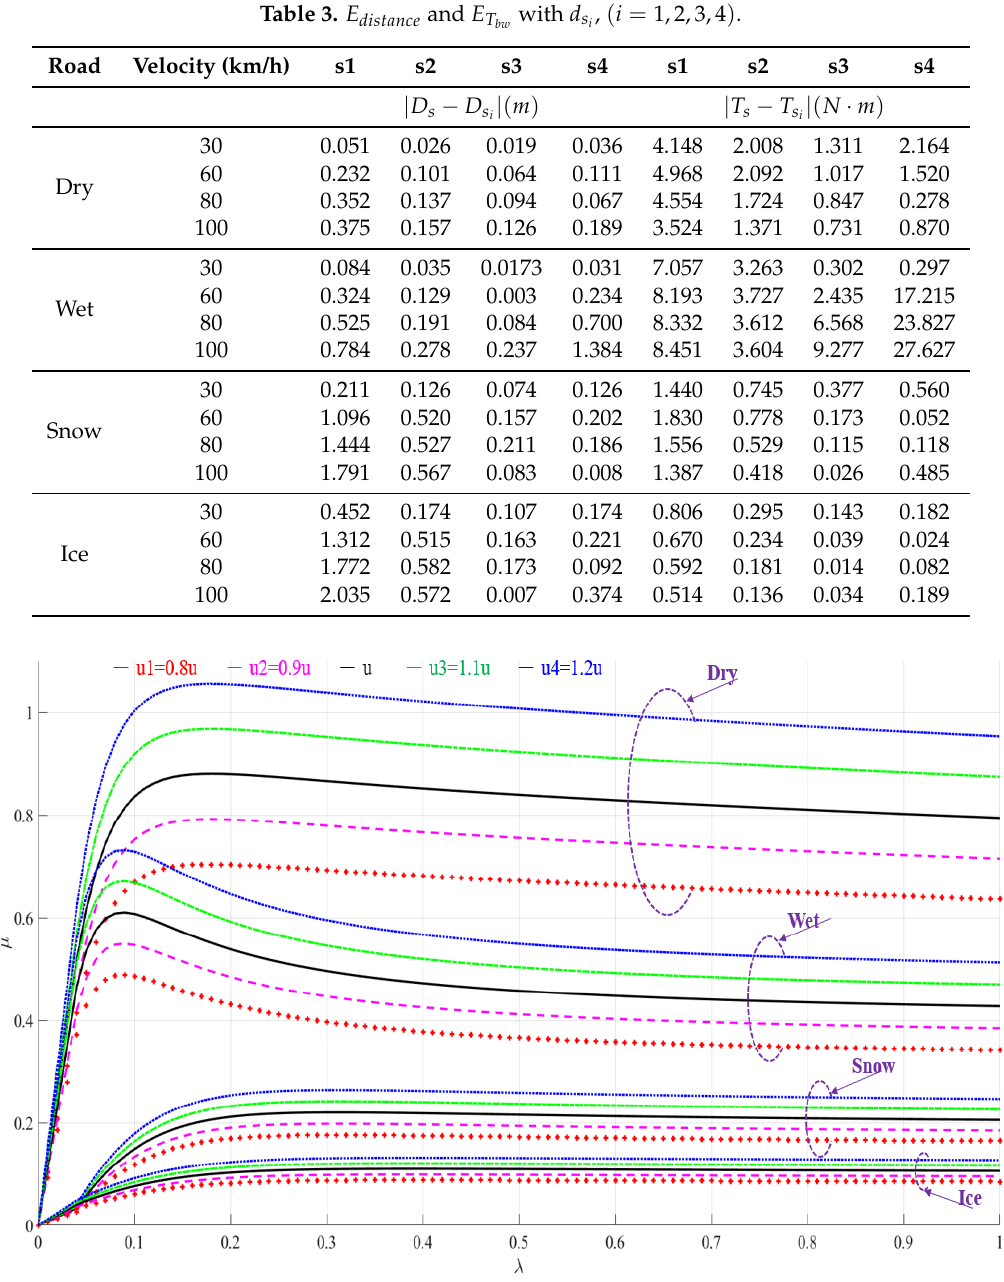
Figure 10. The vertical change of the curve µ ( λ )